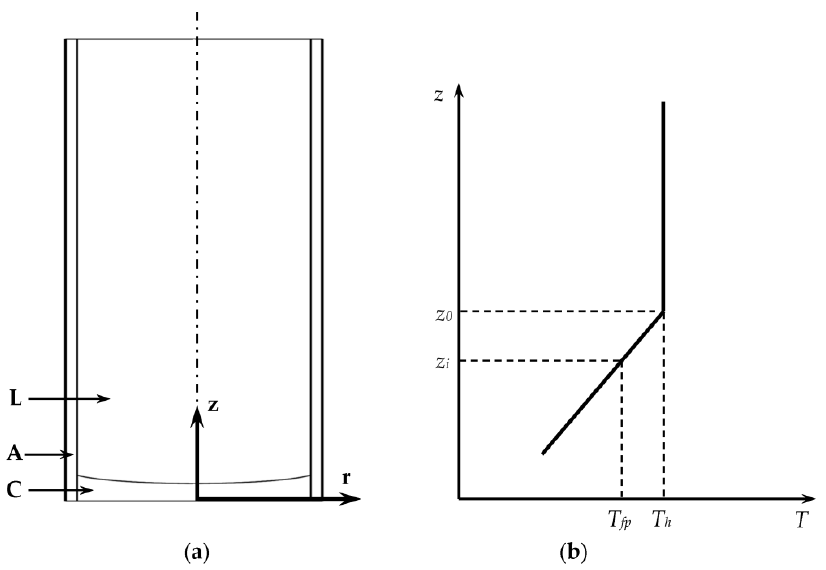
Figure 1. Schematic diagram of the growth system. ( a ) The ampoule and the charge. Regions A, C and L represent the ampoule, the crystal, and the solution, respectively. The inner diameter, outer diameter, and the length of the ampoule are 30 mm, 33 mm, and 60 mm, respectively. ( b ) The temperature boundary condition. z i and T fp represent the position of the growth interface and the growth temperature, respectively.